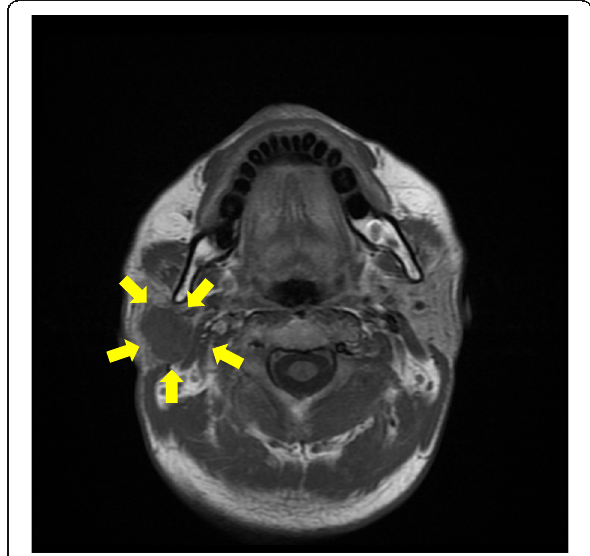
Fig. 1 T1-weighted magnetic resonance imaging (MRI) showing a low-enhanced, well-defined mass in the right parotid gland